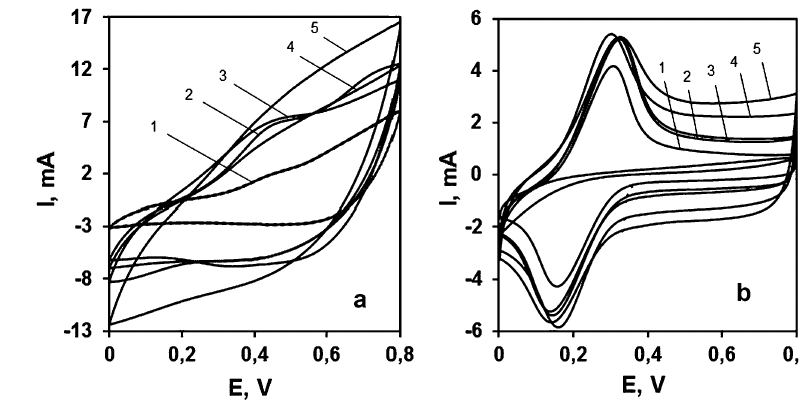
Fig. 3 Characteristic cyclic voltammograms of as-deposited ( a ) and annealed ( b ) cobalt KNO 3 electrolyte at different deposition times: 1–60 s,